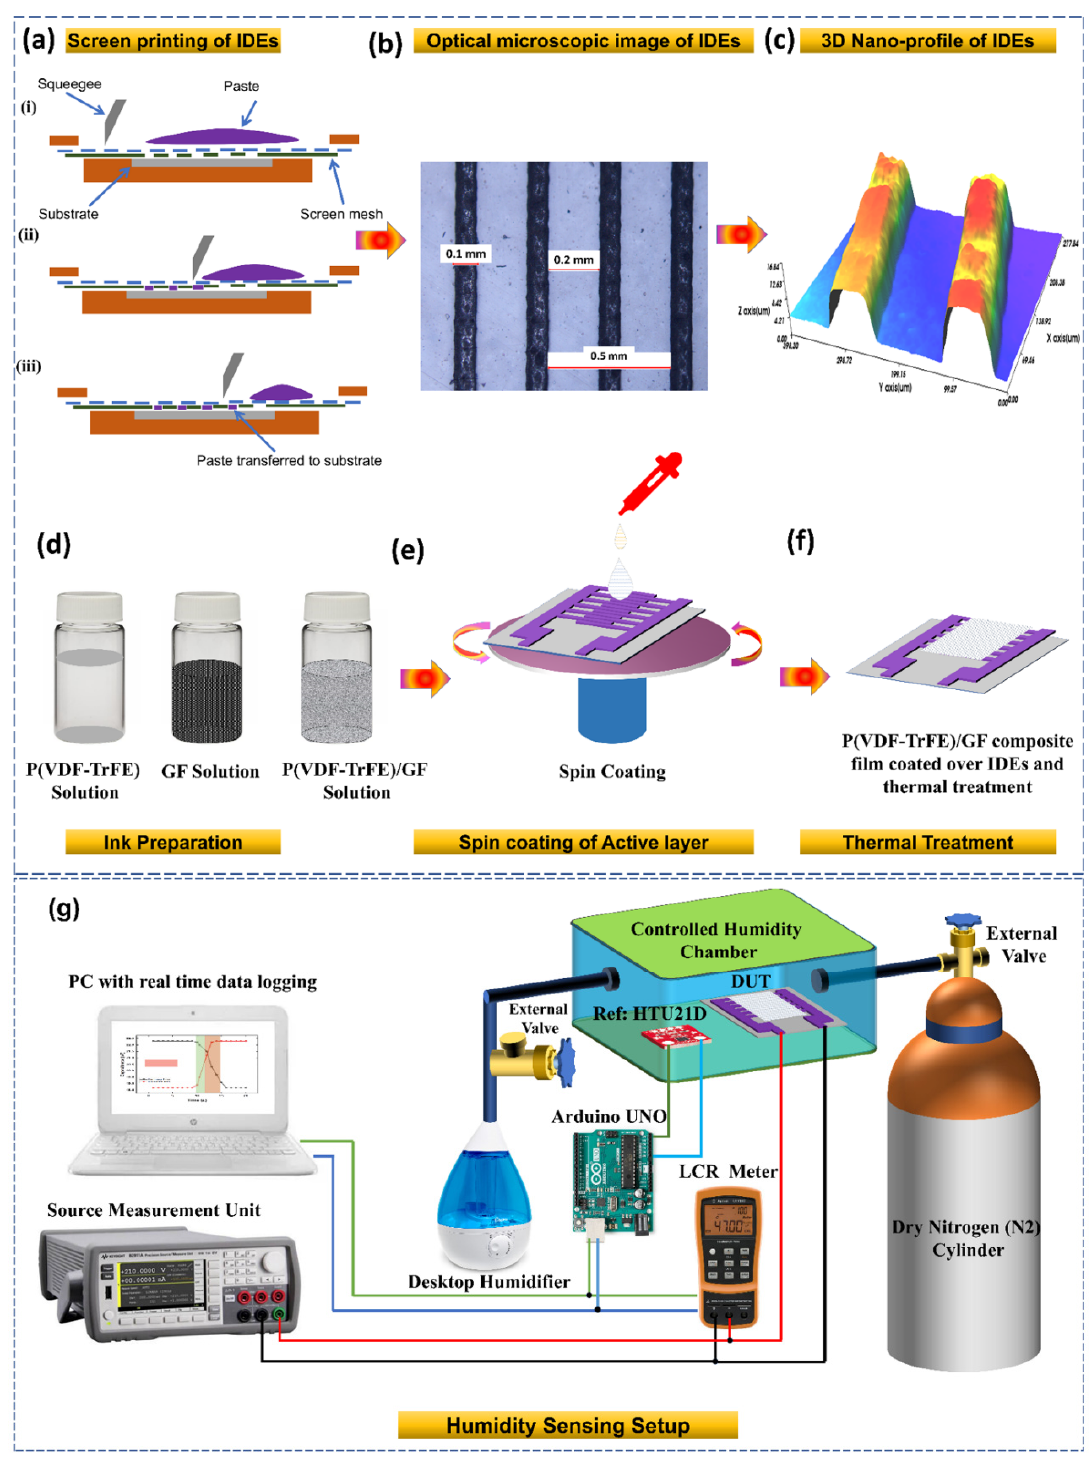
Figure 1. ( a ) Fabrication process of interdigital electrodes. ( b ) Optical microscopic image of IDEs. ( c ) 3D Nano-profile of IDEs. ( d ) Schematic diagram of the ink preparation of P(VDF-TrFE), GF solution and their composite. ( e ) Deposition of active layer through spin coating ( f ) Thermal treatment of the composite film at 80 ◦ C. ( g ) Experimental setup used to characterize the humidity